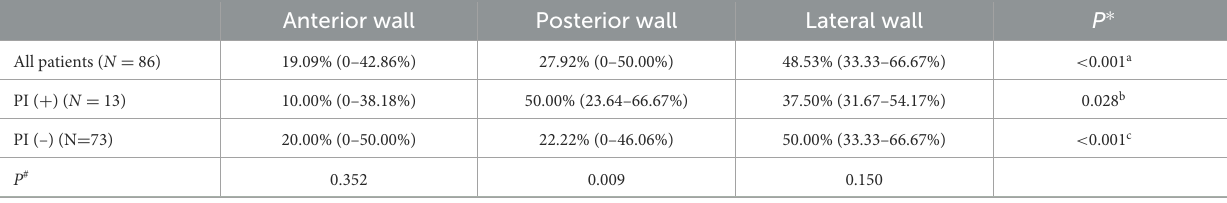
TABLE 3 Basilar artery plaque